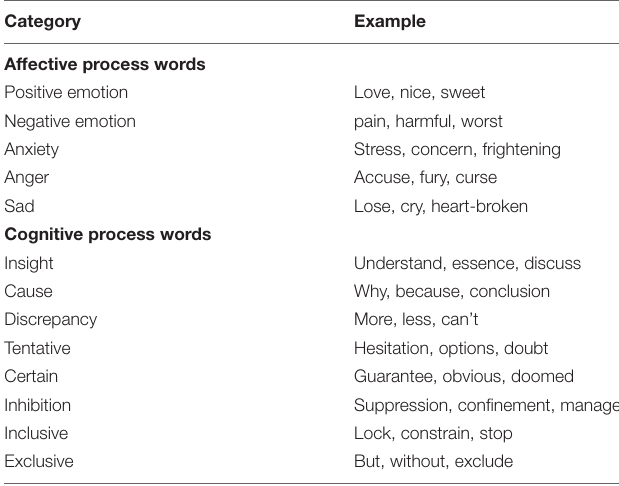
TABLE 3 | Examples on affective processes words and cognitive words in